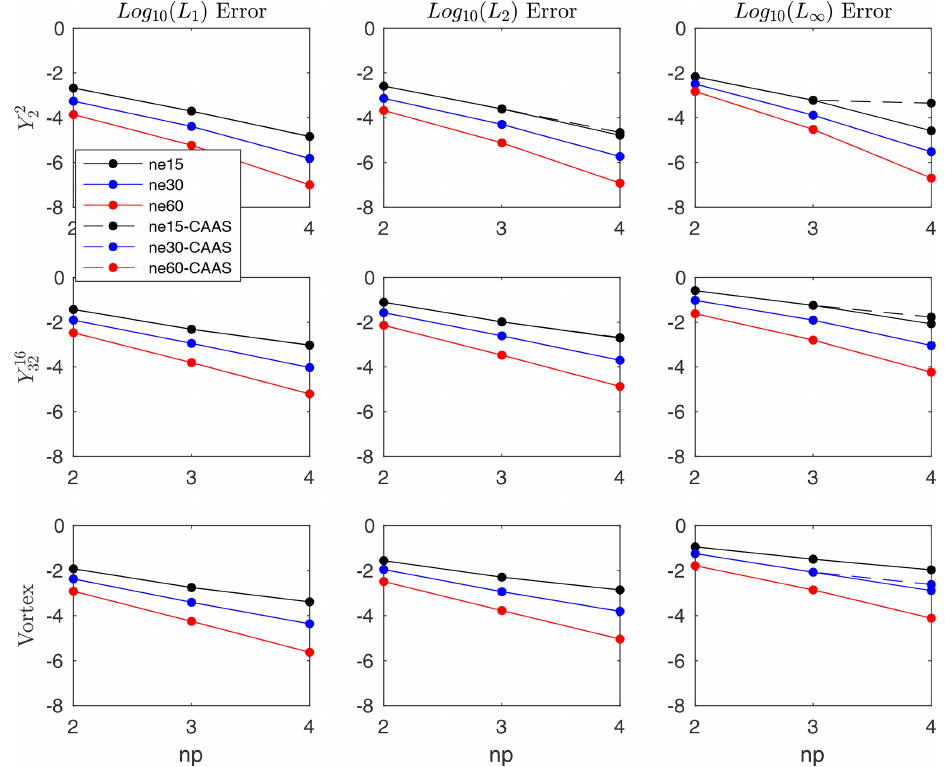
Figure 3. Convergence test for finite-element to finite-volume remapping from a cubed sphere to latitude–longitude mesh using local bounds preservation for three different test cases. The setup is the same as it was for finite-volume to finite-volume remapping, with the dashed lines showing the results using CAAS with local bounds preservation and the solid lines showing the results without CAAS. Table 1. Error norms for remapping from an ne90 cubed sphere to a 1 ◦ latitude–longitude